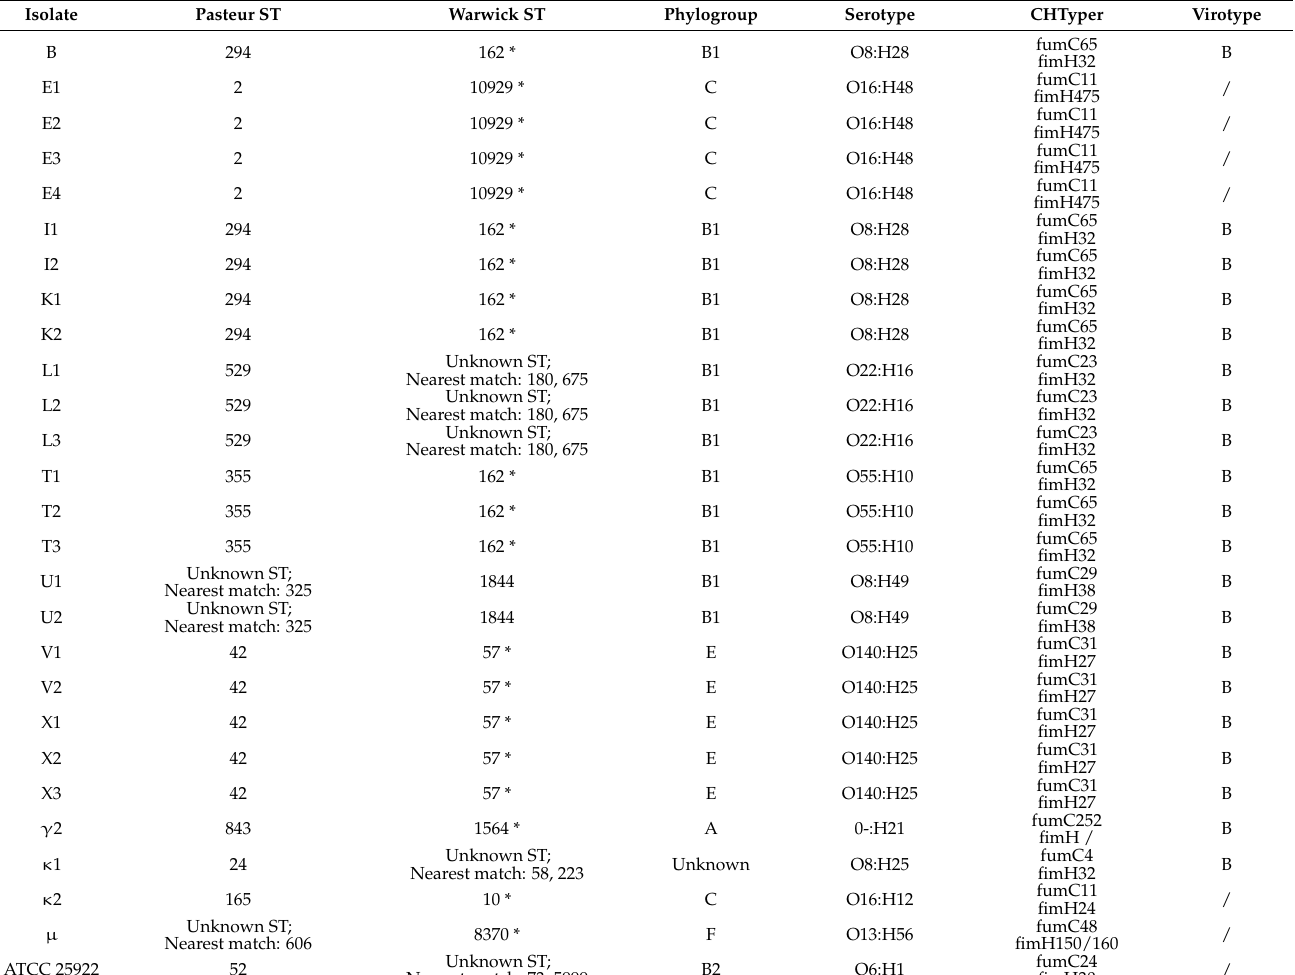
Table 4. Overview of the multilocus sequence type, phylogroup, serotype, FimH, and FumC type and virotype of the Escherichia spp. isolates obtained from zoo